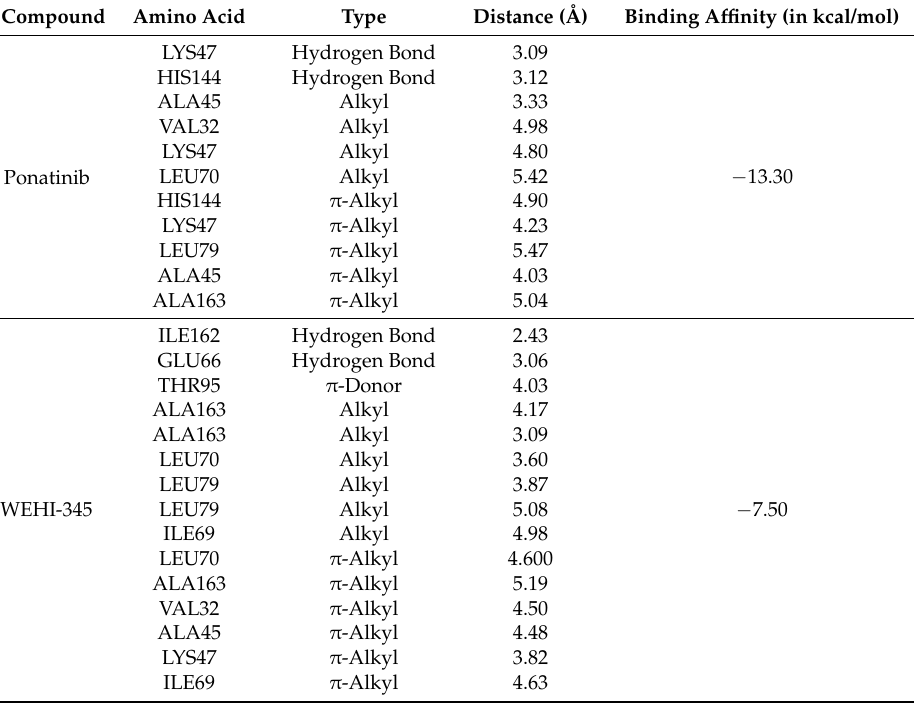
Table 3. Interactions between RIPK2 (PDB 4C8B) and ponatinib or WEHI-345, obtained using the AutoDock/Vina software are shown.